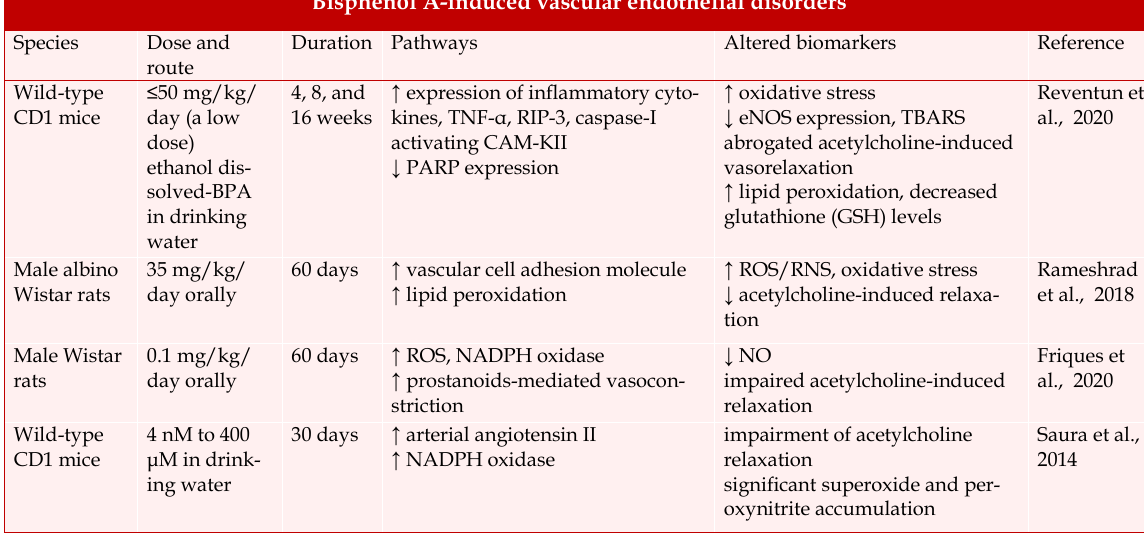
Bisphenol A-induced vascular endothelial